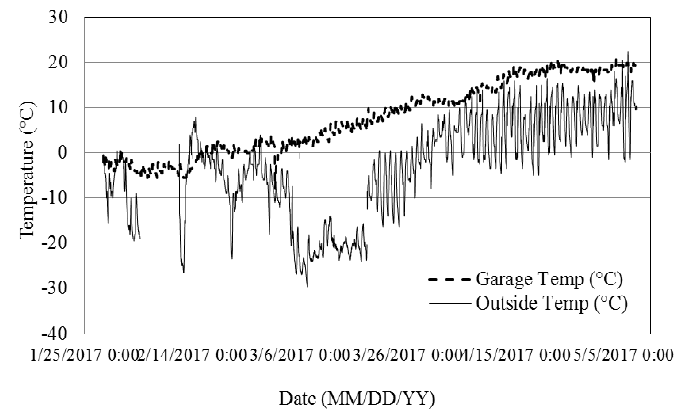
Figure 10. RTD measured glycol supply and return temperatures.